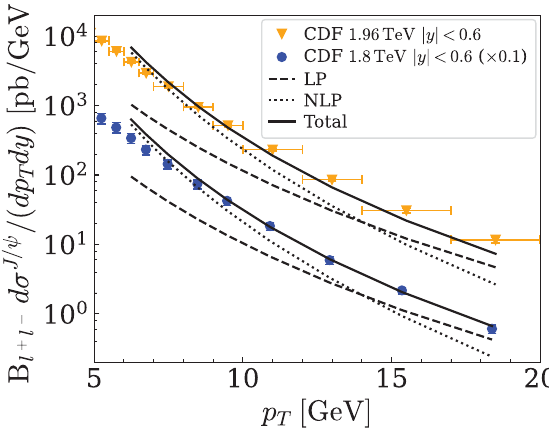
Figure 4. Theoretical calculations for the differential cross section of prompt J /ψ production at mid rapidity in hadronic collisions at Tevatron energies. Experimental data from CDF are taken from Refs. [ 11, 12 ]